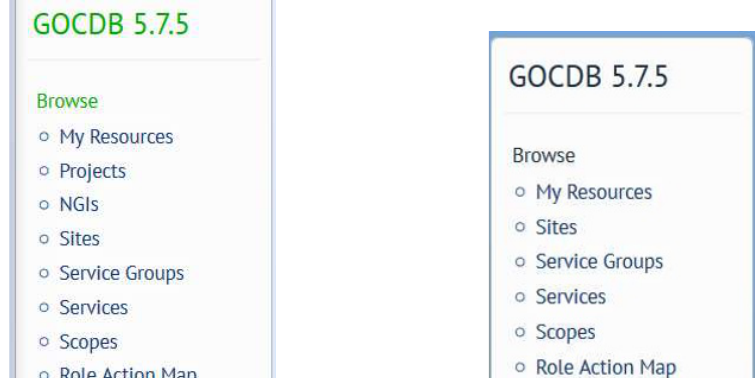
Fig. 2. The traditional GOCDB menu (left) and the simplified menu provided by the EOSC-hub scope specific view.